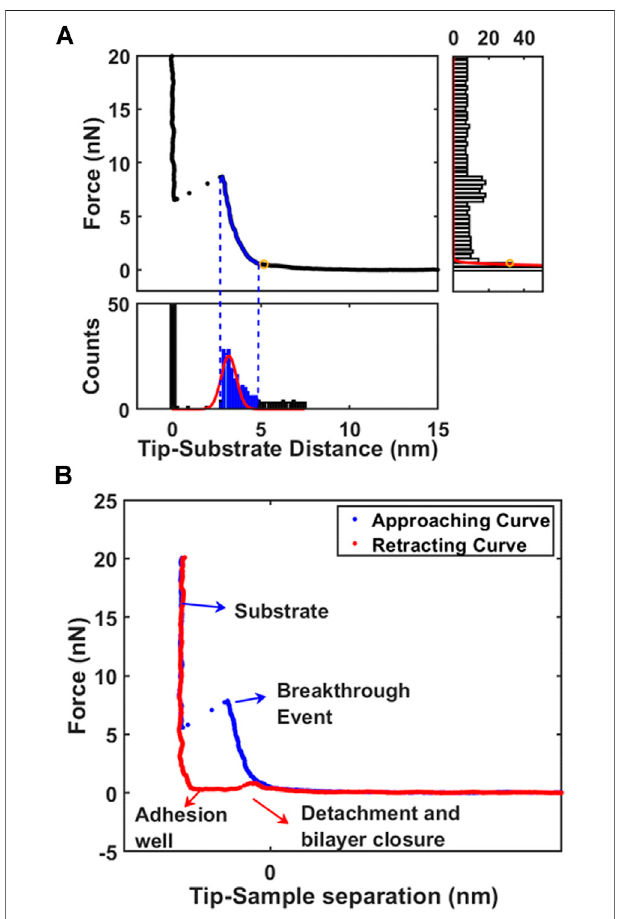
FIGURE 1 | The analysis of supported phospholipid bilayers. (A) Working principle of algorithm to identify automatically the contact point on fi rst layer by decomposition of force curve (FC) with X-Y histograms. (B) Typical force curve (approaching and retracting) acquired on phospholipid bilayer highlighting important